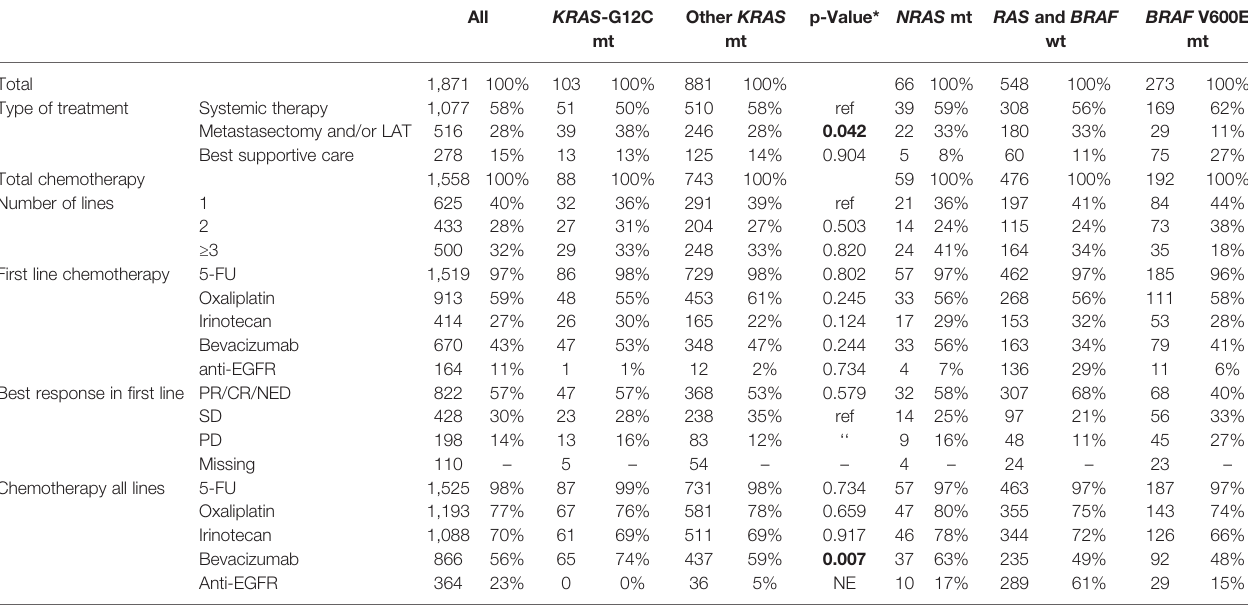
TABLE 2 | Treatment according to the type of mutation.